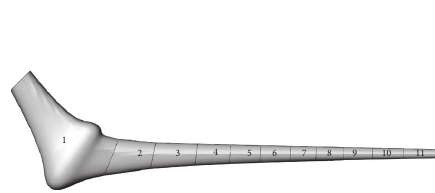
Figure 14: Functionally graded stem with eleven layers.